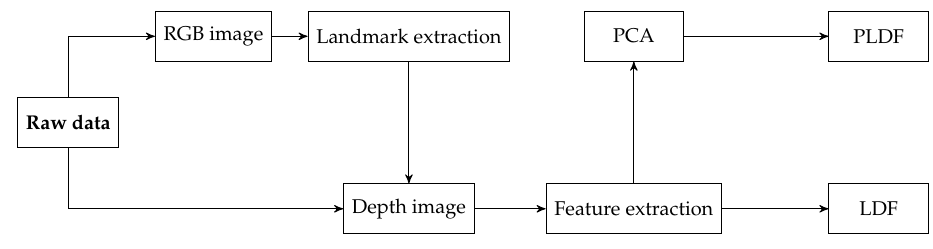
Figure 17. Workflow of the PAD method proposed in [77]